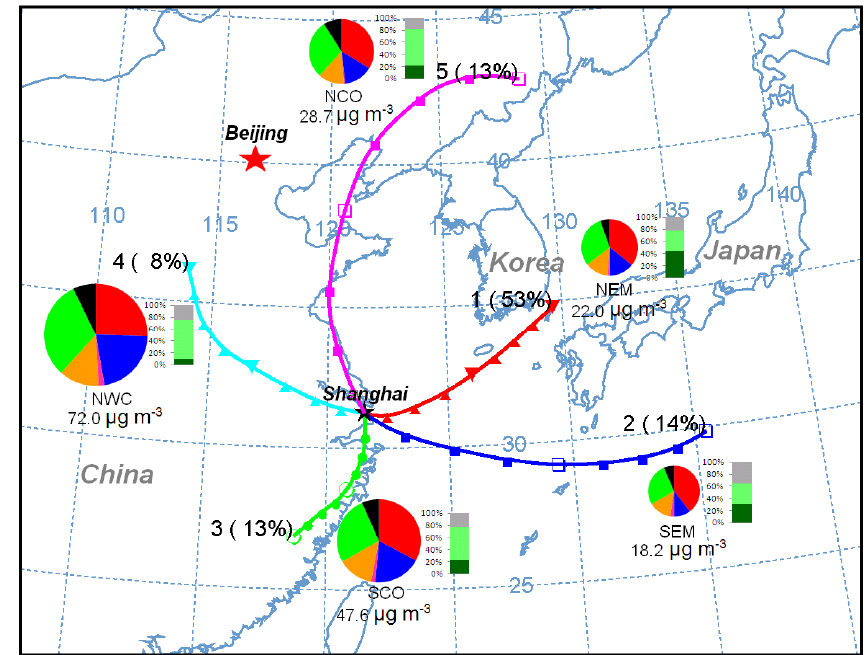
Fig. 5. Back trajectory clusters and the corresponding mean PM 1 compositions during the campaign. The five clusters are northeasterly marine (NEM) BTs, southeasterly marine (SEM) BTs, southerly costal (SCO) BTs, northwesterly continental (NWC) BTs, and northerly coastal (NCO) BTs.